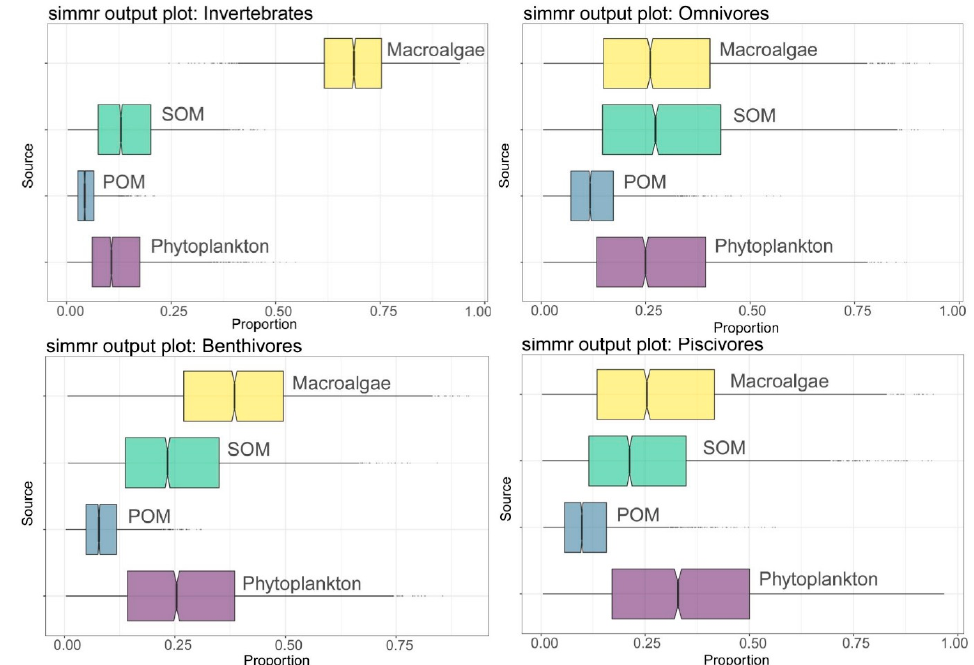
Figure 5. Relative contribution of different basic energy sources to consumers. Yellow boxes represent macroalgae; green boxes represent SOM; blue boxes represent POM; purple boxes represent phytoplankton.